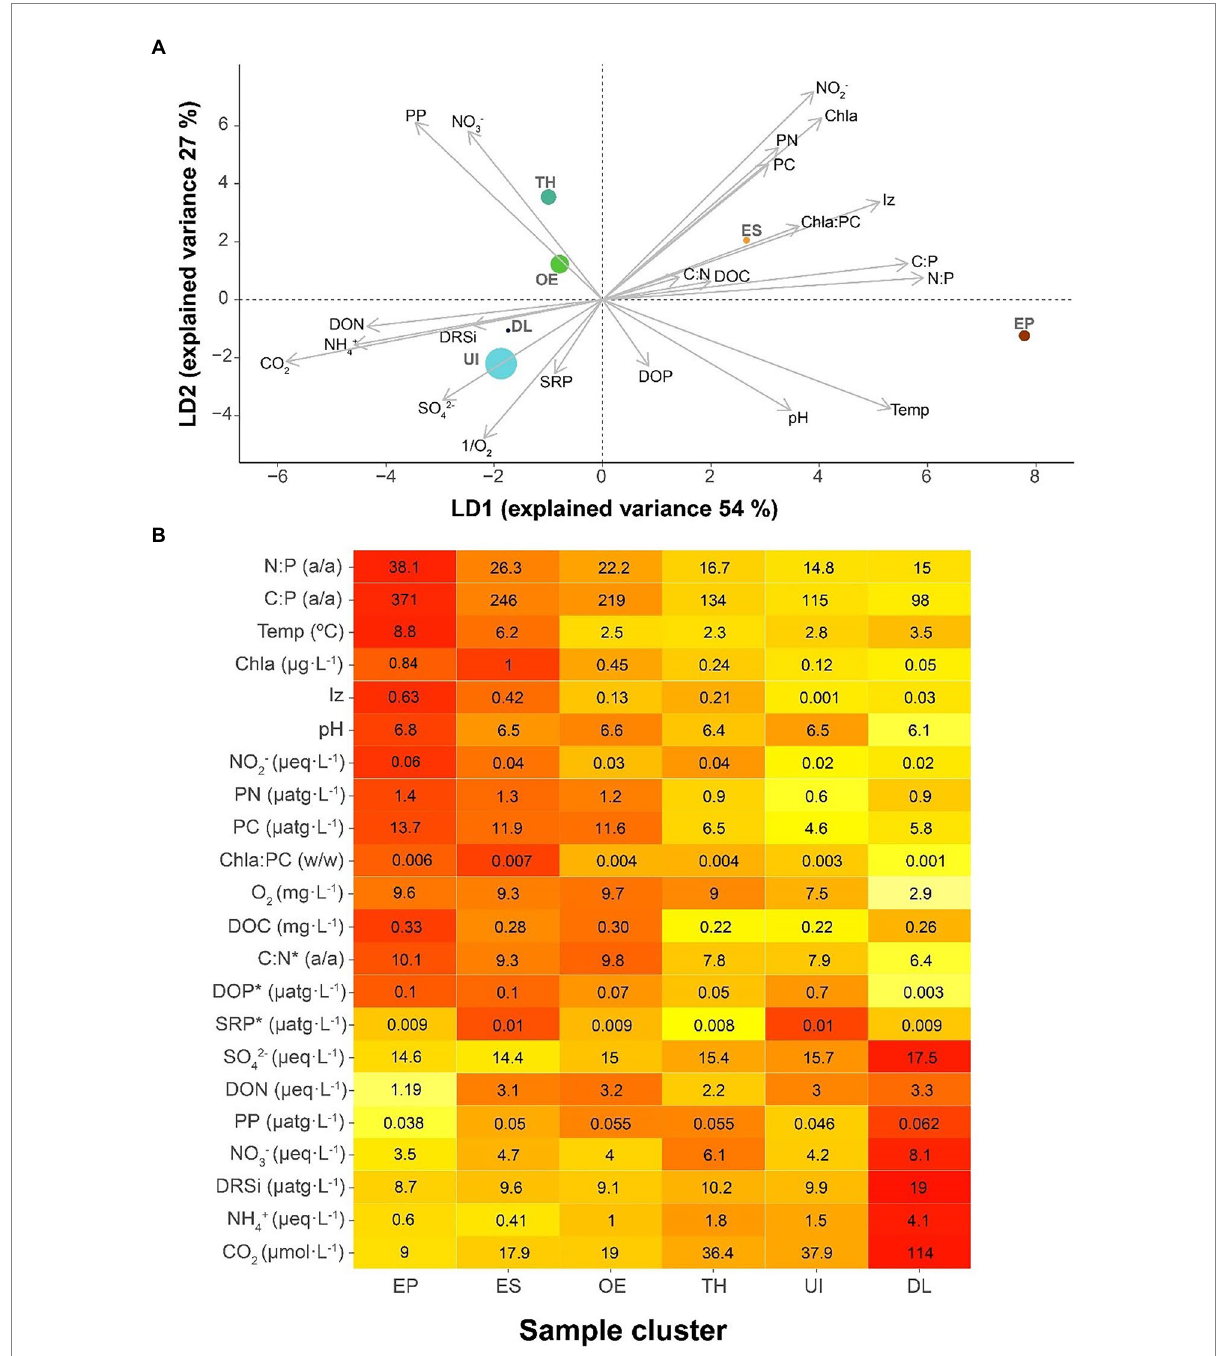
FIGURE 4 Characteristics of the bacterial seasonal clusters’ environment. (A) Bacterioplankton clusters in a discriminant environmental space. Clusters: UI (under-ice), TH (thaw and hypolimnion), ES (early stratification), EP (epilimnion), OE (overturn and early under-ice), and DL (deep layer). The symbol size of each cluster is proportional to the number of samples included. (B) Heat map indicating the average environmental conditions for each bacterioplankton seasonal cluster. The average cluster values clusters indicated within the boxes, and colors indicate the relative rank among clusters, from the highest (red) to the lowest (pale yellow). The variables are sorted according to their loading in the first axis of the discriminant analysis (A) , with the lowest p -values at both extremes and the less relevant variables in the middle. The asterisk (*) indicates no significance in the discriminant